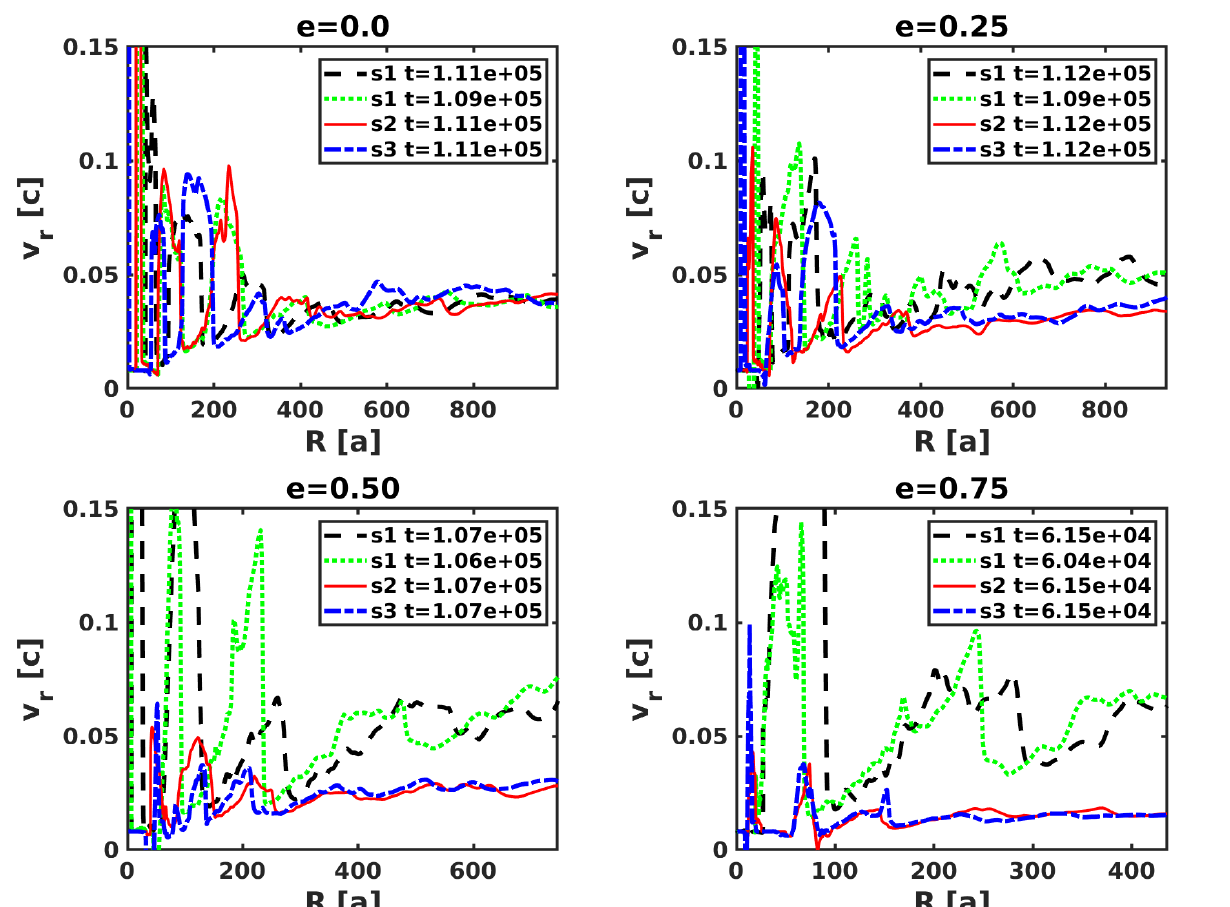
Figure 4. Radial velocity, averaged over sectors s1, s2 and s3, versus R and different orbital eccentricities: e = 0 ( left top panel ); e = 0.25 ( right-top panel ); e = 0.5 ( left-bottom panel ); and e = 0.75 ( right-bottom panel ). An additional curve for the s1 case at a slightly earlier time, is also shown to illustrate the quick variability of the flow properties on top of its longer term behavior.